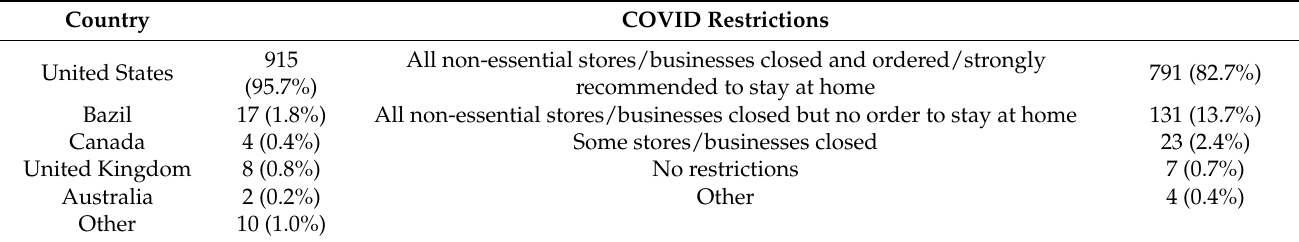
Table 1. Demographics of participants: Country and level of COVID